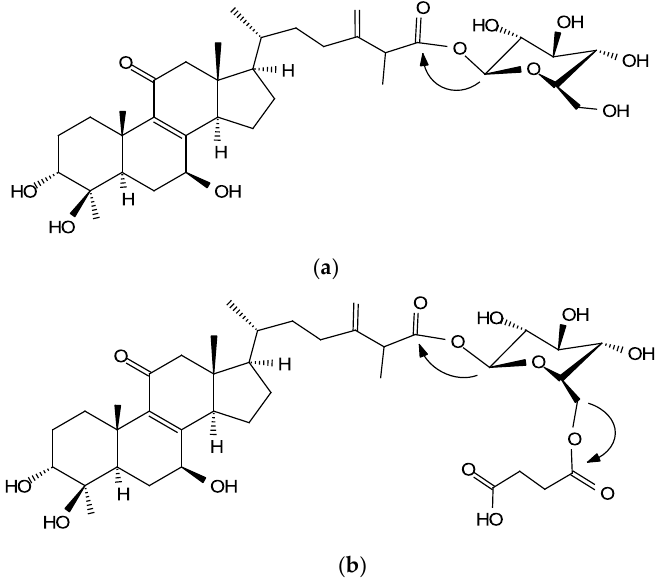
Figure 2. The structure and the key HMBC correlations (arrows) of compound ( 1 )/( 3 ) ( a ) and compound ( 2 )/( 4 ) ( b ).